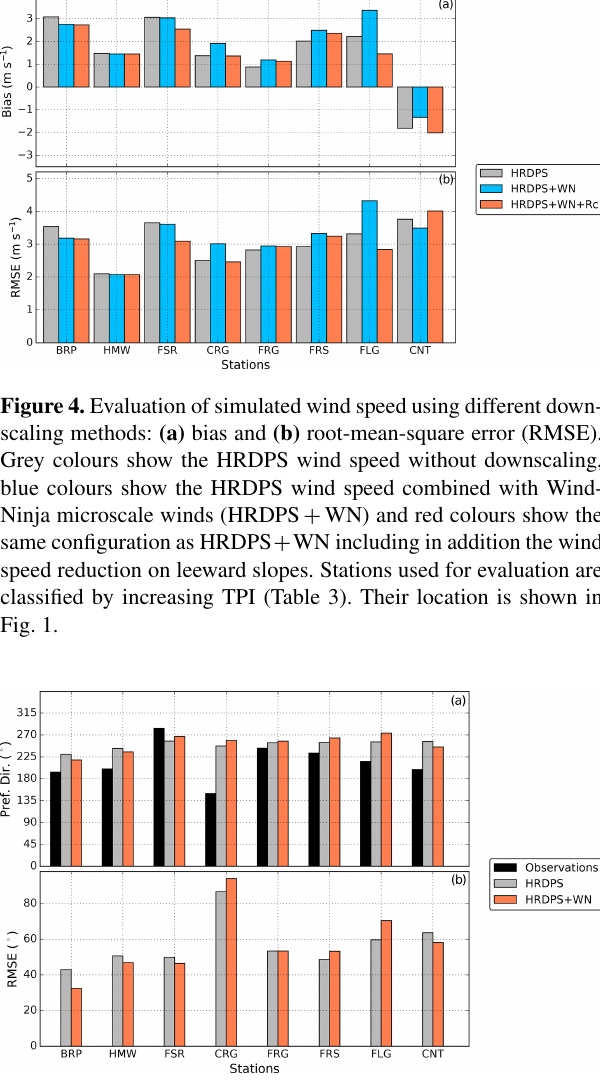
Figure 5. Same as Fig. 4 for wind direction: (a) preferential wind di- rection and (b) root-mean-square error (RMSE). Error metrics were computed for wind direction only when observed wind speed was larger than 3ms − 1 . Configuration HRDPS + WN + Rc is not shown since the wind direction is unchanged compared to HRDPS +